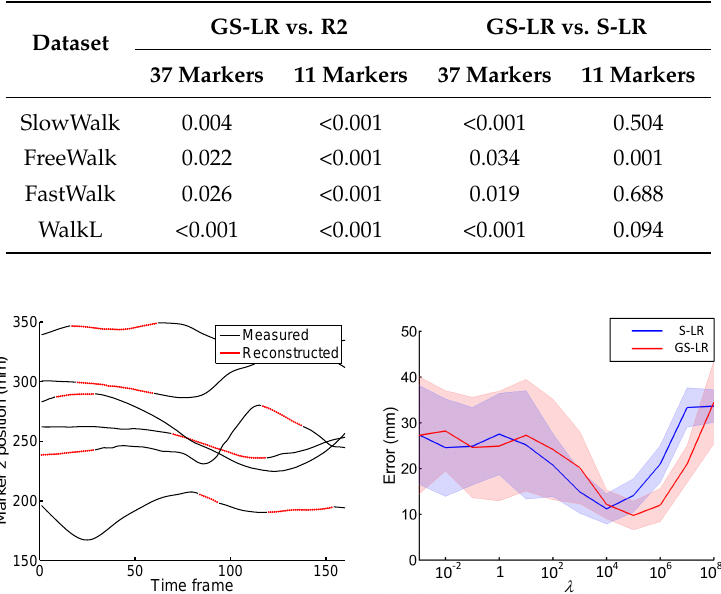
Table 1. Performance comparison ( p -values) of tested methods using a pairwise Wilcoxon signed rank test, for the four gait datasets.